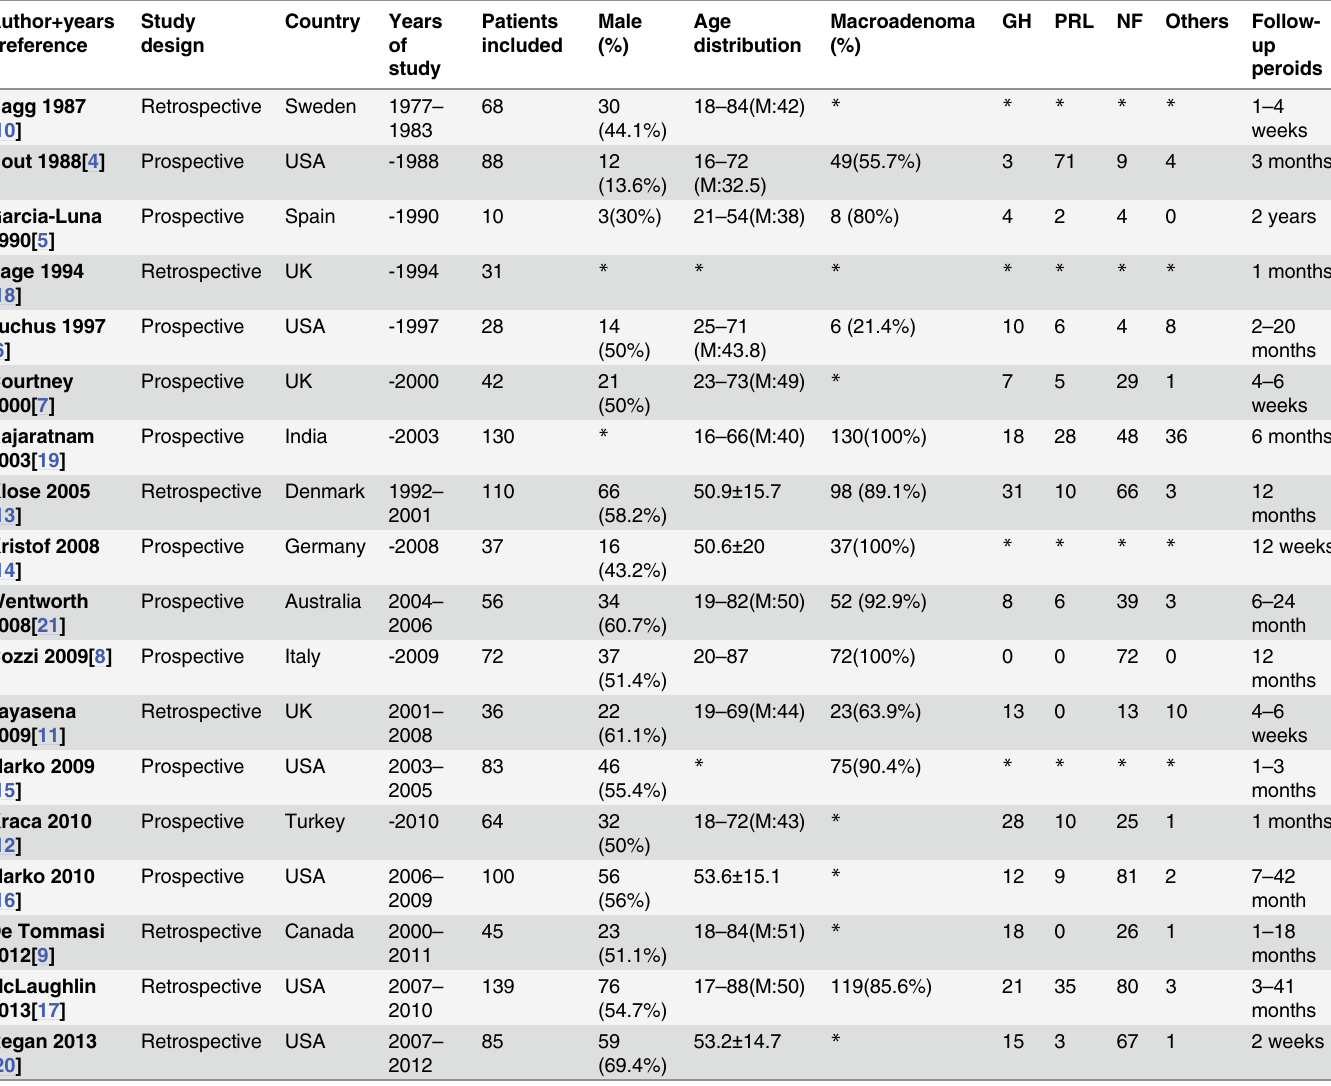
Table 1. Overview of 18 included